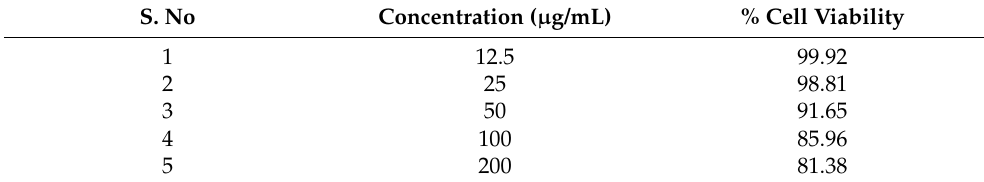
Table 6. Concentrations vs. % cell